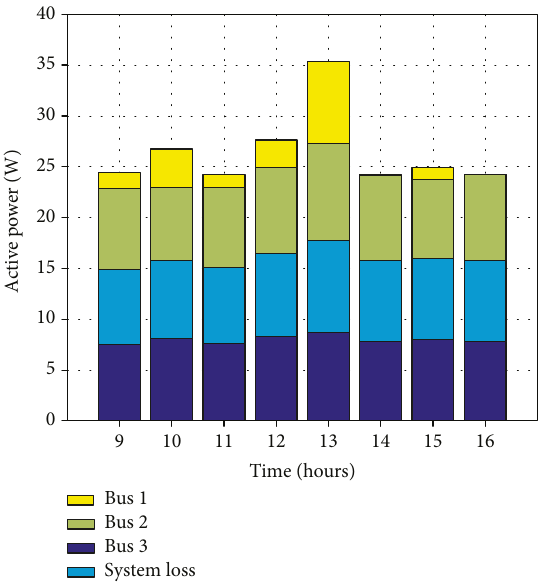
Figure 15: Distributed power in the experimental veri fi cation of multiple-source con fi